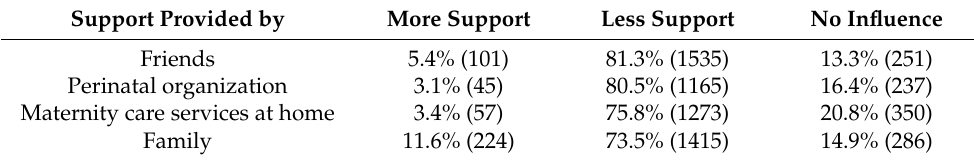
Table 5. Impact of the pandemic on the extent of support during breastfeeding ( n =